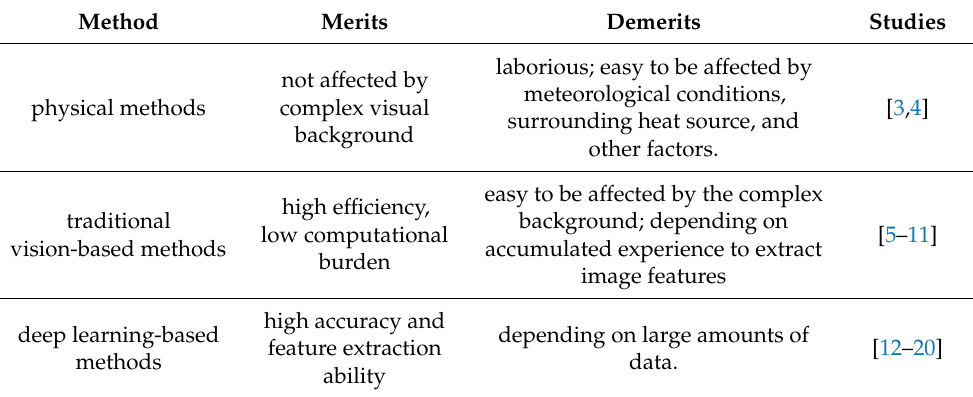
Table 1. A brief summary of the previous related